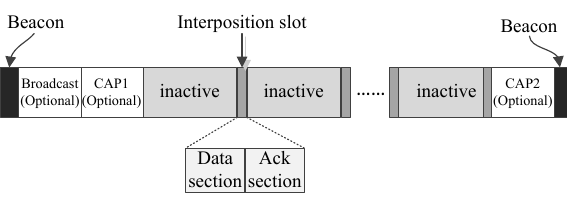
Figure 1. The structure of the medical emergency monitoring (MEM)-MAC